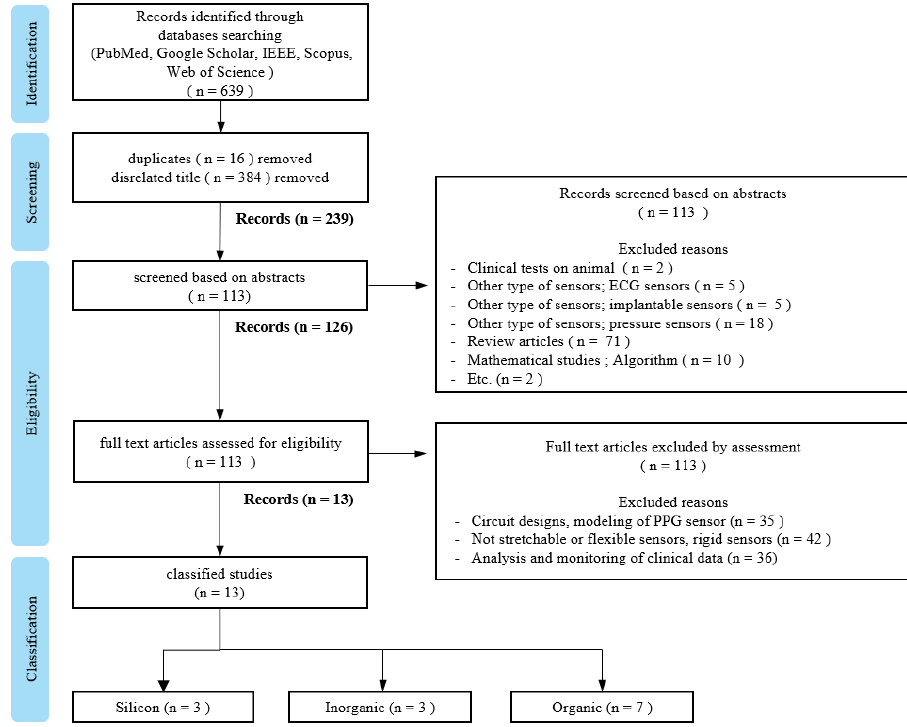
Figure 1. PRISMA flowchart of the identification and selection of studies.